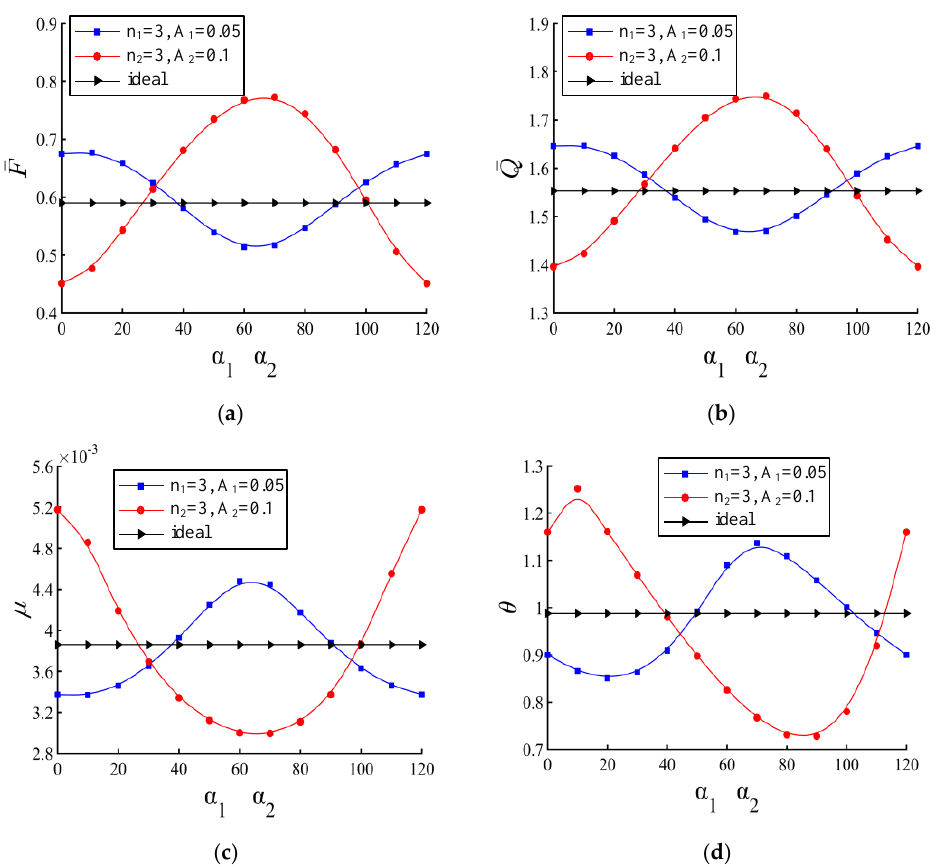
Figure 4. Variations of the dimensionless bearing load capacity ( a ), dimensionless end leakage flow rate ( b ), friction